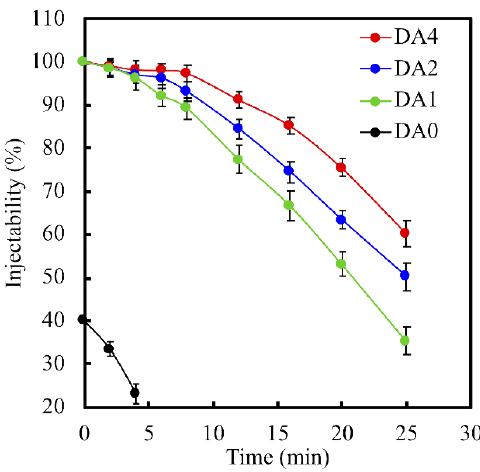
Figure 3. Injectability of various concentration of PDA-coated CS pastes after versus setting time.